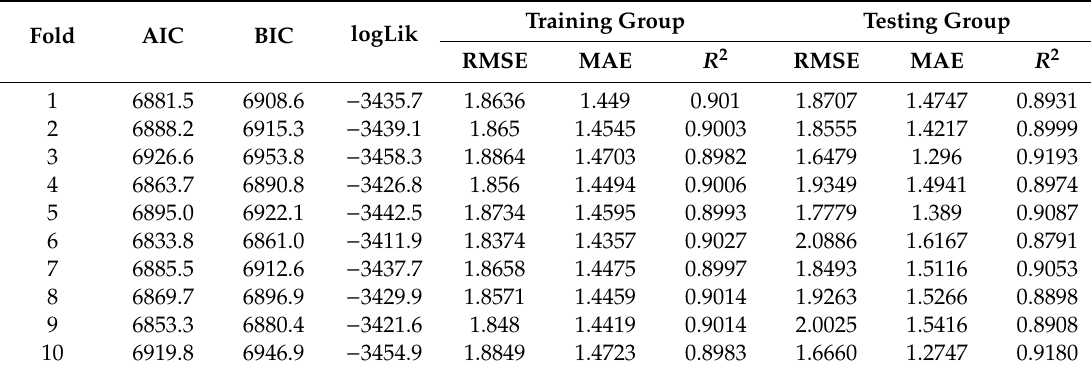
Table 3. Details of 10-fold cross-validation for base models.